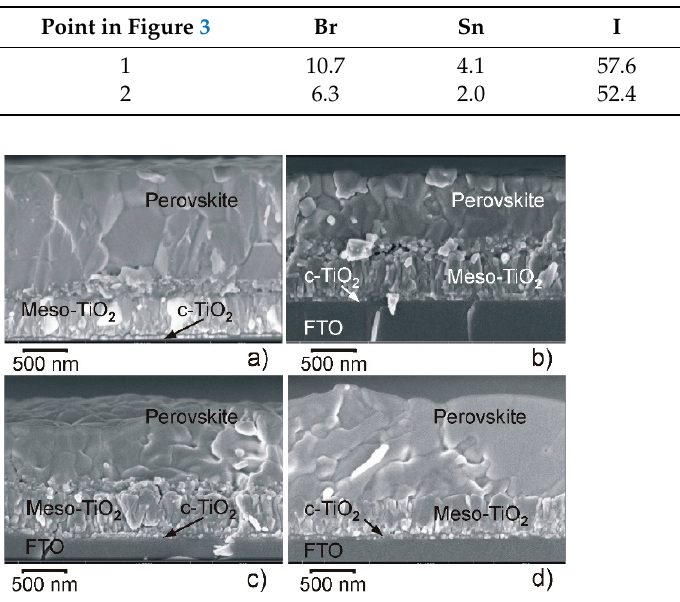
Figure 4. Cross-sectional SEM images of the fractures of the perovskite cells. Cs concentration (in %) is: ( a ) 0, ( b ) 10, ( c ) 20, ( d ) 40. Magnification is 65,000X.